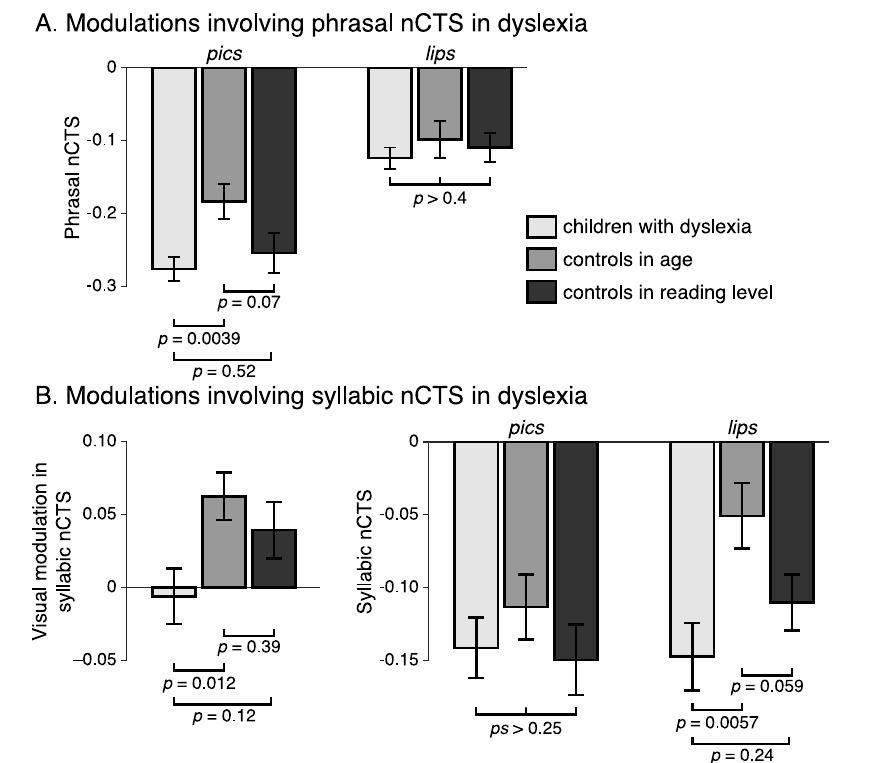
Fig 4. Comparison between children with dyslexia and controls in the measures of nCTS significantly related to reading abilities. (A) Modulations involving phrasal nCTS. Displayed are the mean and SEM within groups (dyslexia, control in age, and control in reading level) of phrasal nCTS in the conditions with (lips) and without (pics) visual speech information. Values of nCTS were averaged across hemispheres and babble noise conditions for phrasal nCTS and across hemispheres and all noise conditions for syllabic nCTS. (B) Modulations involving syllabic nCTS. On the left is the visual modulation in syllabic nCTS. The right part is as in (A). S4 Data contains the underlying data for this figure. nCTS, normalized cortical tracking of